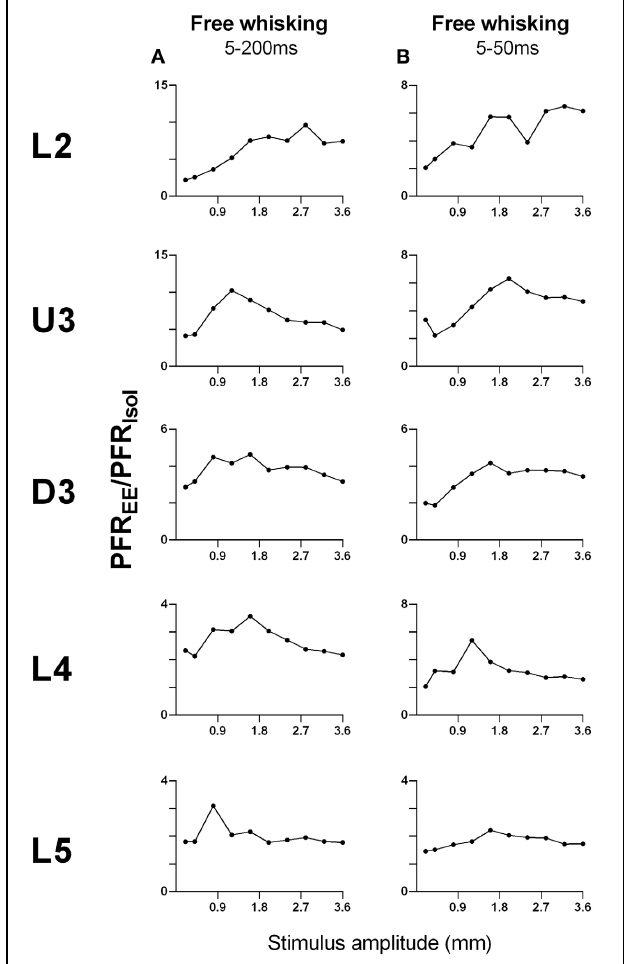
FIGURE 8 | Peak firing rate ratios in EE vs. Isol animals for free whisking stimulus. PFR EE /PFR Isol across all stimulus amplitudes in (A) the 5–200ms analysis window, and (B) the 5–50ms analysis window of the free whisking stimulus. For the 5–200ms analysis window, there was a non-monotonic increase in PFR EE /PFR Isol , especially in layers U3–L5. For the 5–50ms window, the PFR EE /PFR Isol also increased non-monotonically and was followed by a plateau/decrease in magnitude of increased responsiveness in EE vs. Isolated animals. Laminar designations: L2, Layer 2; U3, Upper Layer 3; D3, Deep Layer 3; L4, Layer 4; L5, Layer 5. Each row of data comes from the same lamina as designated by the labels on the